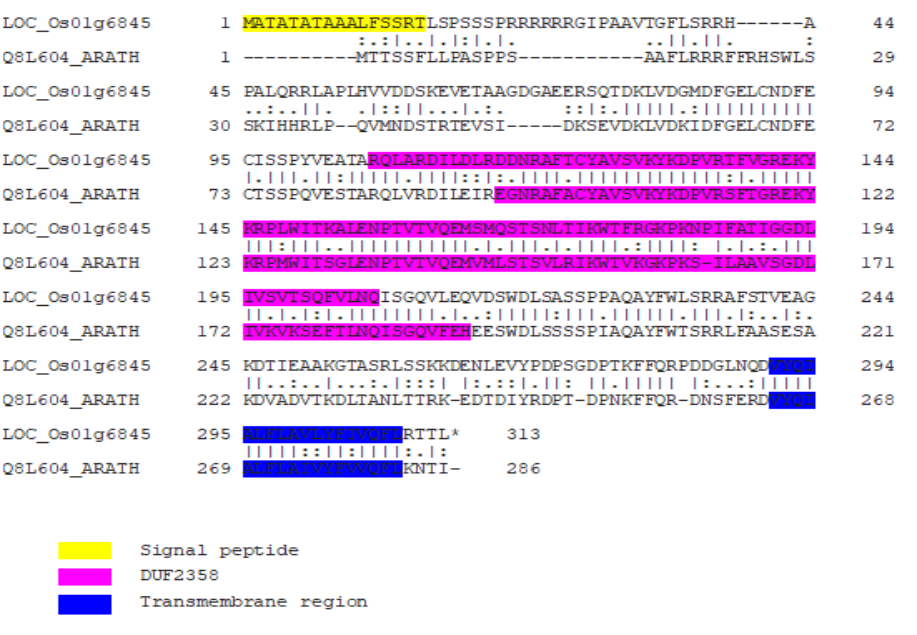
Figure 8. Amino acid sequence alignment of LOC_Os01g6845 and Q8L604, the protein product of at1g65230 . Different motifs are indicated in yellow, pink, and blue. LOC_Os01g6845 sequence was obtained from the Rice Genome Annotation Project [9] and that of Q8L604 was obtained from The Arabidopsis Information Resource [10].